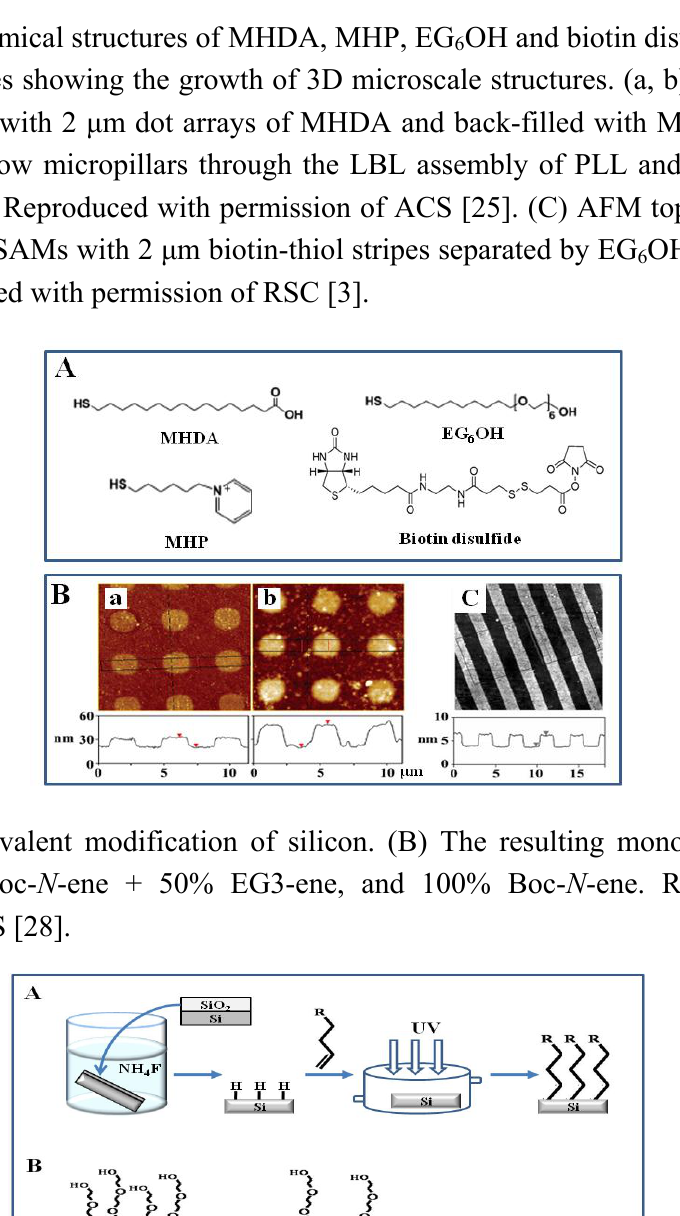
OH and biotin disulfide. (B) AFM 6 OH stripes on gold 6